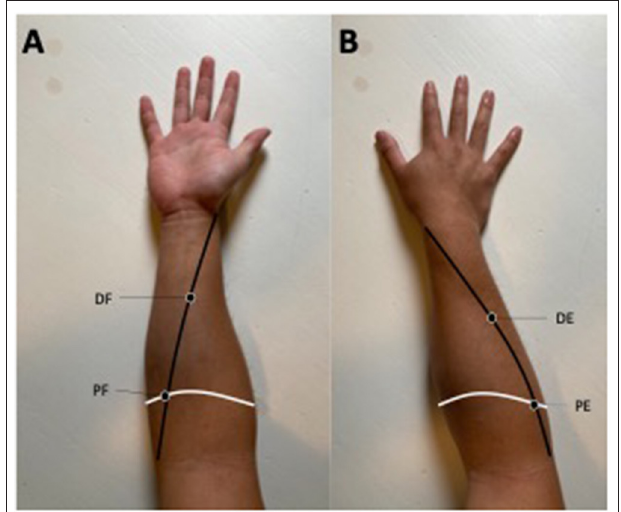
FIGURE 4 | (A) Represents the anterior face of the forearm while (B) represents the posterior part of the forearm. The white line determines the most prominent part of the forearm. The black line represents the line from the medial epicondyle (A) and the lateral epicondyle (B) to the radial styloid. These lines determine the four measurement sites: PF, the proximal flexor; DF, the distal flexor; PE, the proximal extensor; DE, the distal extensor. This figure represents the position of point of measurement and not the position of the MyotonPro protocol